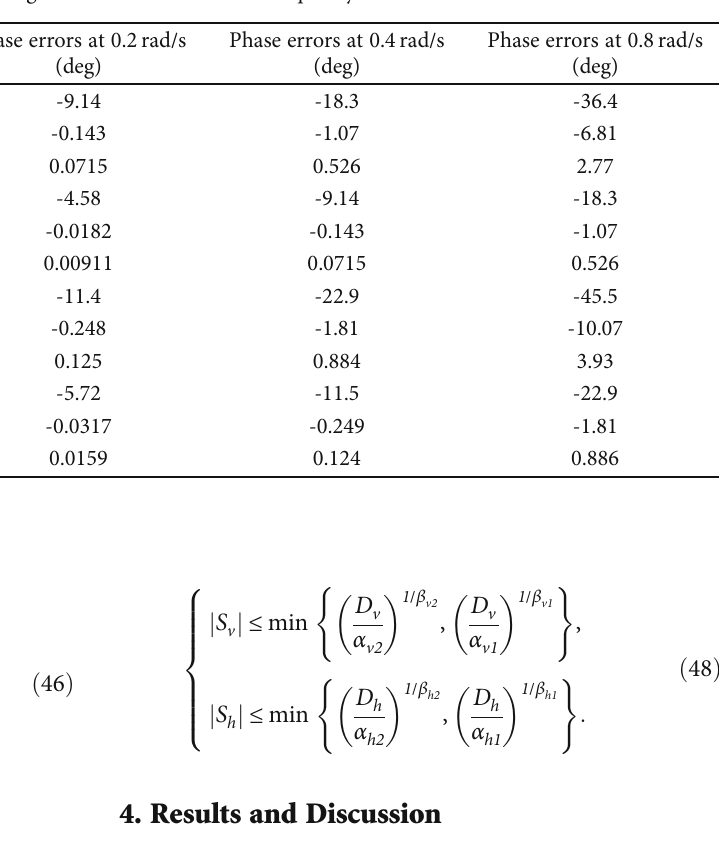
Table 2: Phase errors of high-order LESO in the low-frequency